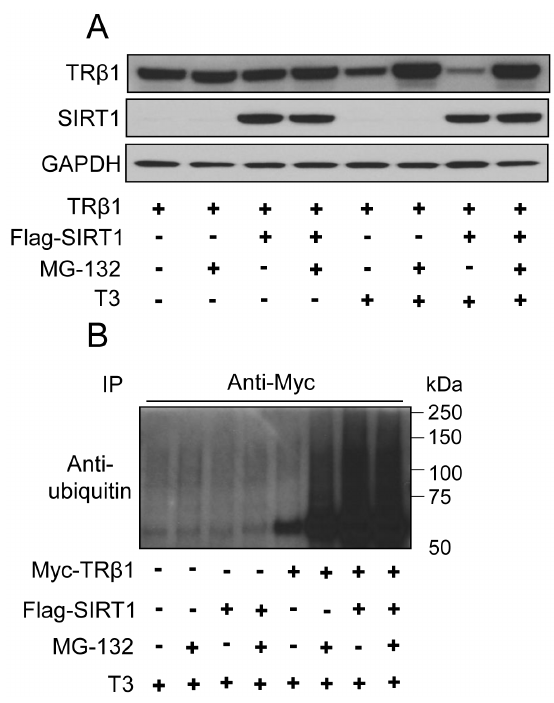
Figure 5. SIRT1 induces proteasome-dependent TR b 1 degra- dation and ubiquitination. ( A ) Western analysis of 293T cells transfected with myc-TR b 1 and SIRT1 expression vectors and treated with T 3 for 24 hours and 20 m M MG-132 for 6 hours. Note the MG132- dependent increase in TR b 1 levels observed with SIRT1 and T 3 . The lower panel represents GAPDH loading control. ( B ) SIRT1 leads to ubiquitination of TR b 1 protein. The panel represents western analysis of extracts of 293T cells transfected with myc-TR b 1 and SIRT1 expression vectors and treated with T 3 for 24 hours and 20 m M MG-132 for 6 hour, immunoprecipitated with anti-myc antibody and blotted with anti- ubiquitin antibody.